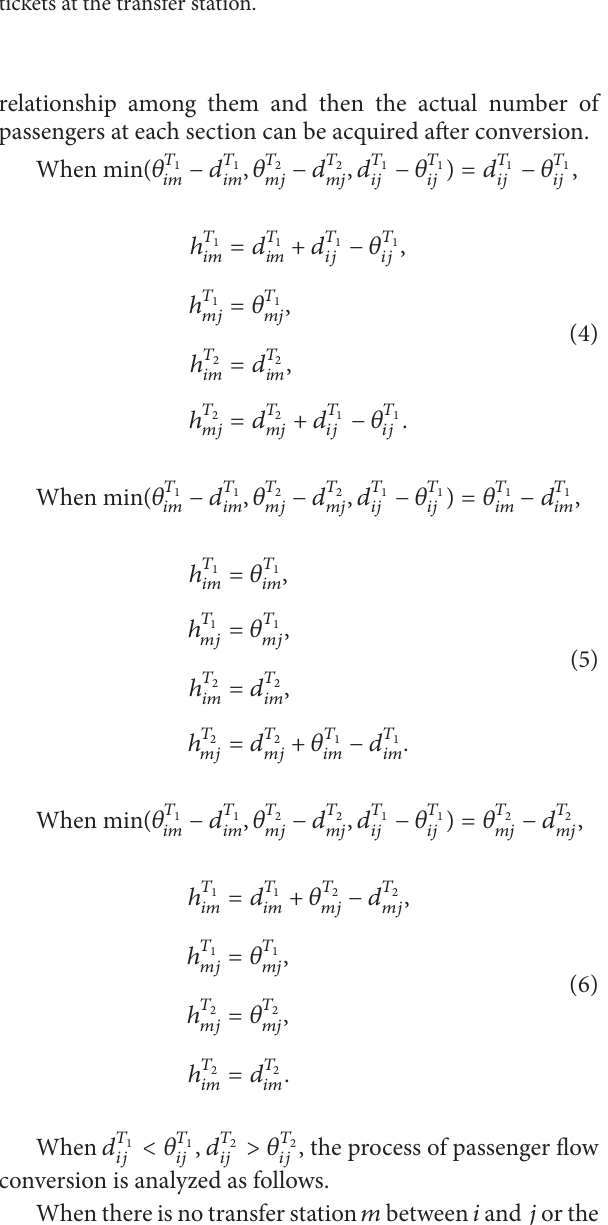
Figure 2: Relational graph of remaining passengers and remaining tickets at the transfer